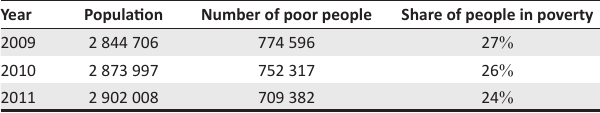
TABLE 2: Poverty status in